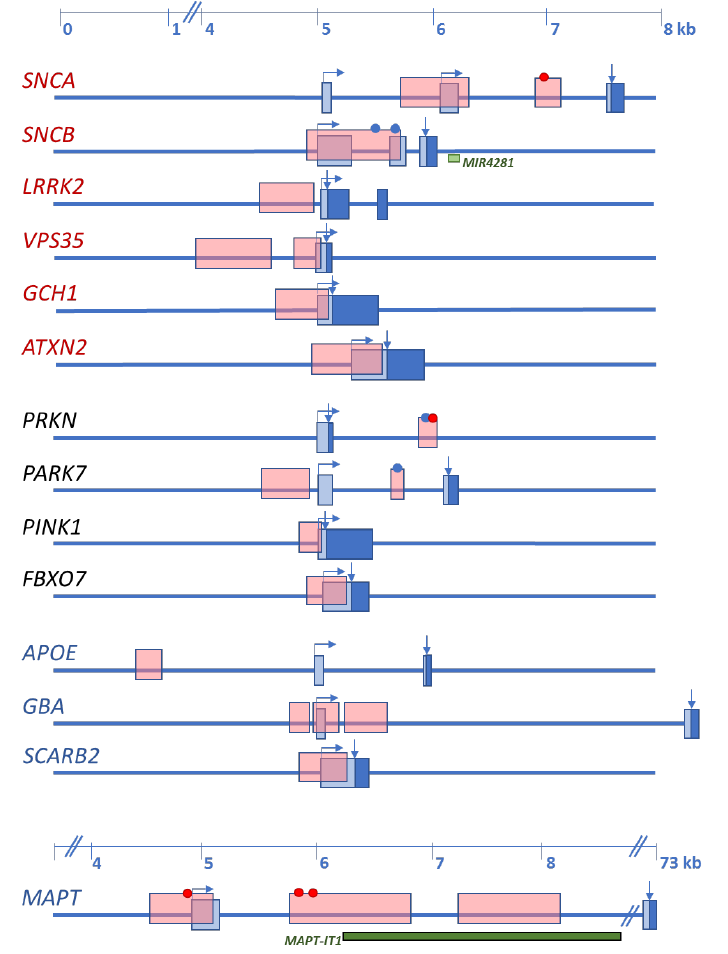
Figure 1. Schematic representation of the initial exon(s) of Lewy body disorders (LBD)-causing and the four main LBD-risk modifying genes with CpG islands. Names of the genes are indicated at the left. In red are autosomal dominant disease-causing genes, in black are autosomal recessive disease-causing genes, in blue are main risk factors, identified by genome-wide association studies (GWAS). Boxes represent exons: light blue — noncoding sequence; dark blue — coding sequence. Horizontal arrows indicate transcription start and direction; vertical arrows indicate the CDS start. Dots indicate CpG islands studied for methylation changes, in red is change of methylation levels, in blue is unchanged methylation. Light green box, miRNA gene within the SNCB sequence. Dark green box, lncRNA within the MAPT sequence.